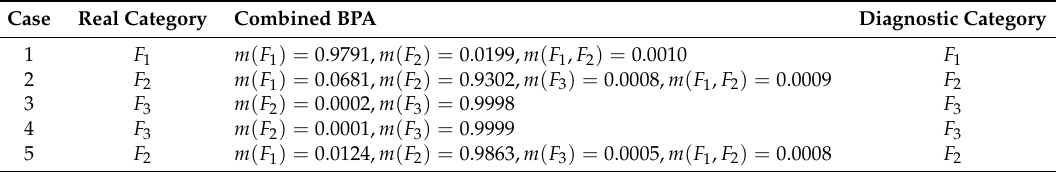
Table 7. Five experiment results of motor rotor fault